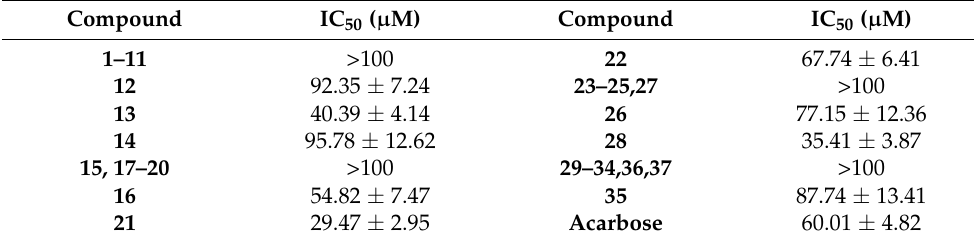
Table 4. α -Glucosidase inhibitory activity of compounds 1 – 37